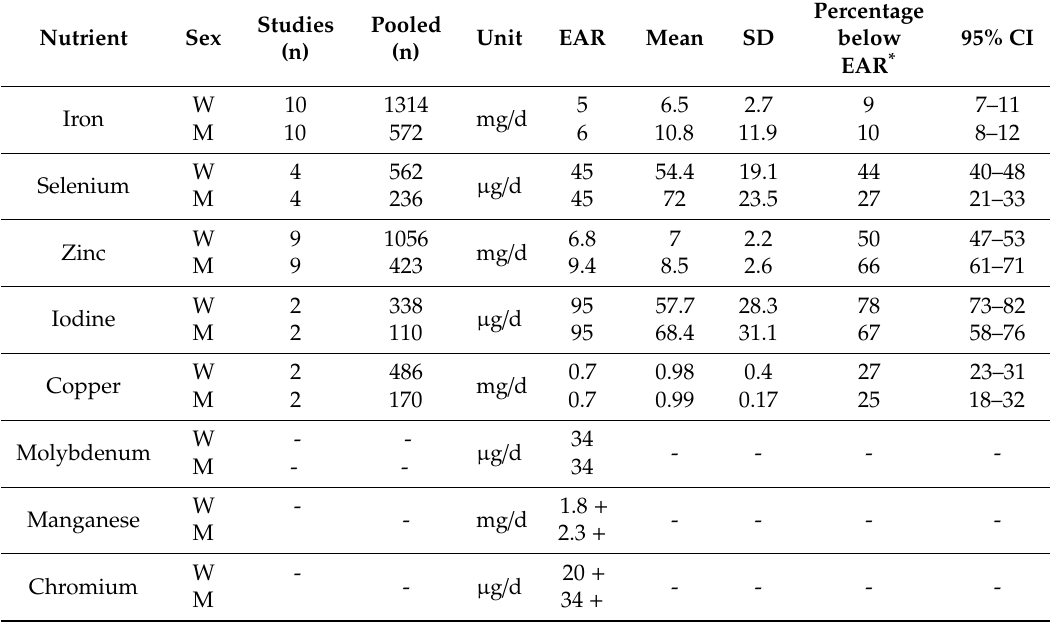
Table 9. Daily trace mineral intake and percentage of inadequate intakes of older adults living in